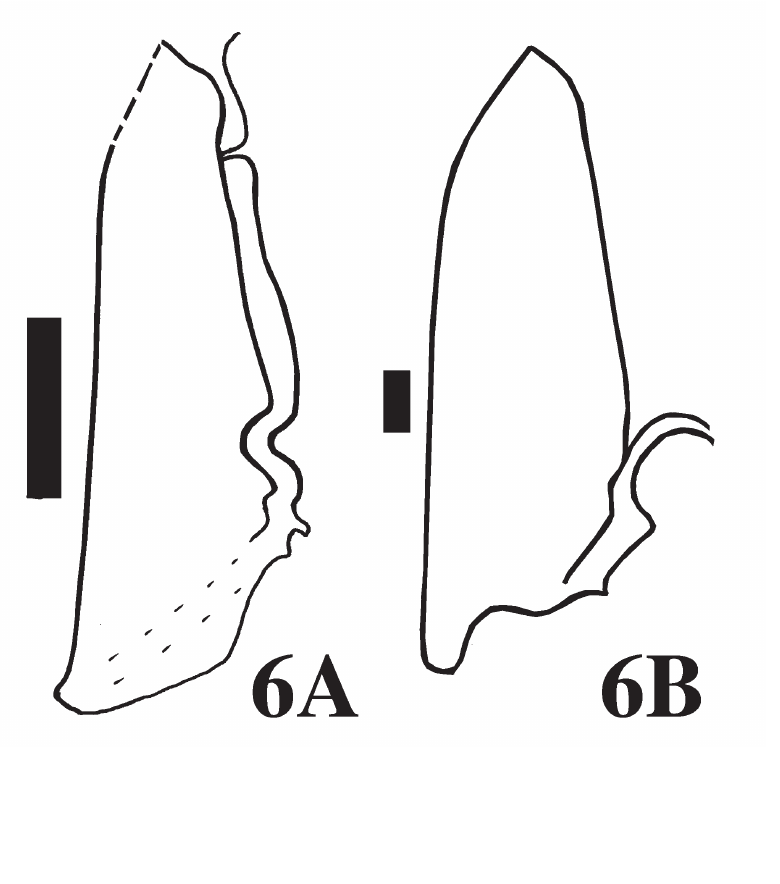
Fig. 6. hypomeron. A . Sharon